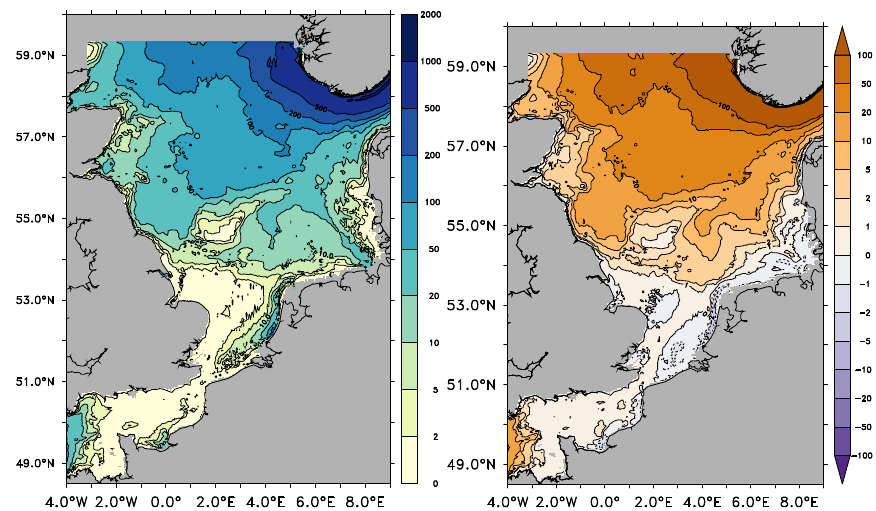
Figure 11. Climatological annual mean potential energy anomaly potential energy anomaly (PEA) (J/m 3 ) of the RCA4-NEMO RCP8.5 ensemble mean ( left ) and its change between period P2 and P0 ( right